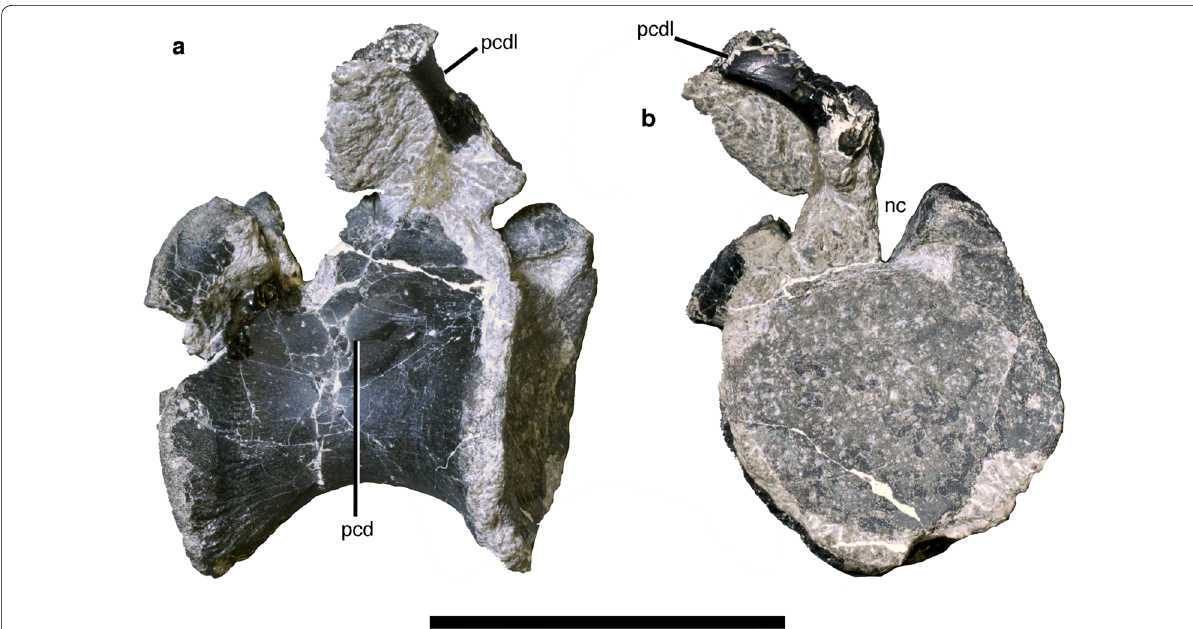
Fig. 16 Sauropodomorph dorsal vertebra from Hallau-Bratelen, MzA NAT 15075. a Left lateral view; b posterior view. nc, neural canal; pcd, pleurocentral depression; pcdl, posterior centrodiapophyseal lamina. Scale bar equals 10